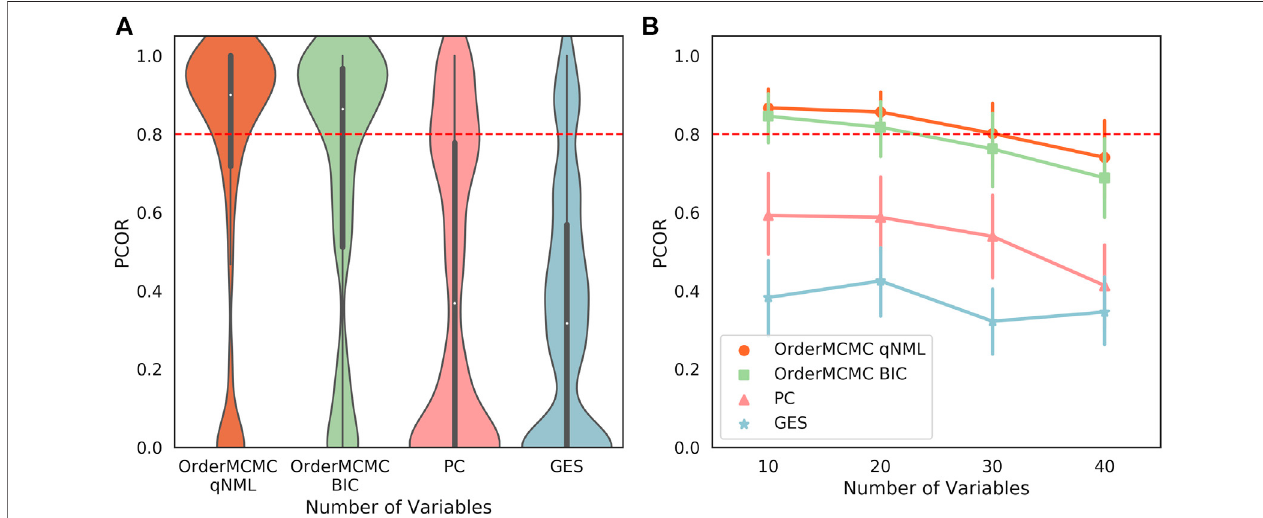
FIGURE 7 | (A) : The PCOR score obtained running the structure learning algorithms on the datasets produced for the Surgo Household dataset datasheet. Performance for OrderMCMC is generally above the set threshold. There are cases where the there are no paths to the target variable, causing the PCOR to be 0. (B) : The PCOR scores obtained by reducing the number of variables. Median performance passes the threshold on the OrderMCMC results when variables are ≤ 20.